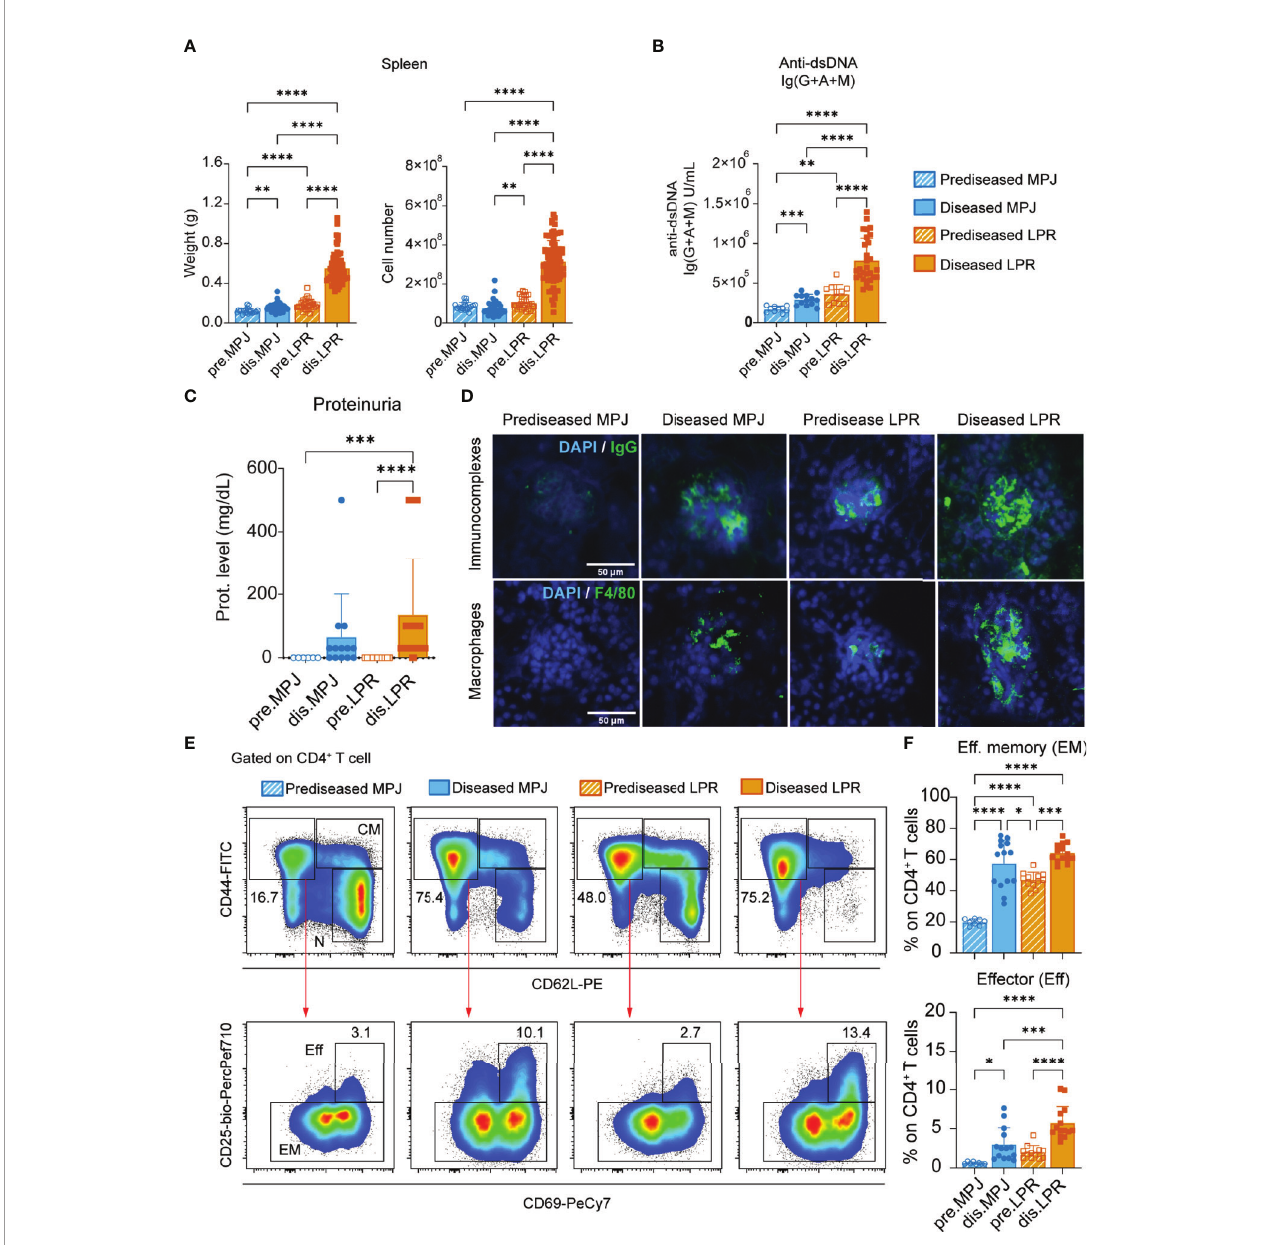
FIGURE 1 | Characterization of MPJ and LPR mice differentiating two lupus disease states. (A) Spleen weight (left) and cell number (right). (B) Levels of Ig(G+A+M) antibodies against double-stranded DNA (dsDNA) determined by ELISA. (C) Protein concentration in urine (0, 30, 100, and 500 mg/dl) determined using urine dipsticks. (D) Representative immuno fl uorescence images from frozen kidney sections (4 – 10 µm) stained with DAPI (4 ′ ,6-diamidino-2-phenylindole) (blue), goat anti- mouse IgG (green) for immunocomplexes (top), and a primary rat anti-mouse F4/80 with secondary goat anti-rat IgG (green) for macrophages (bottom). Scale bar is 50 µm. (E) Representative fl ow cytometry plots gated on splenic CD4 + T cells (CD3 + B220 − CD8 − CD4 + ) showing effector (Eff), effector memory (EM), central memory (CM), and naïve (N) gates. (F) Proportion of effector (Eff: CD44 + CD62L − CD25 + CD69 + ) and effector memory (EM: CD44 + CD62L − CD25 − ) phenotypes among splenic CD4 + T cells. The data represent the mean ± SD: *P < 0.05; **P < 0.01; ***P < 0.001; ****P < 0.0001 by one-way ANOVA with a Tukey multi-comparison post-test. Each point represents a single animal: prediseased MPJ (pre.MPJ), n = 20 (A) 10 (B) 6 (C) and 8 (E, F) diseased MPJ (dis.MPJ), n = 40 (A) 13 (B) 13 (C) and 14 (E, F) ; prediseased LPR (pre.LPR), n = 31 (A) 11 (B) 12 (C) and 12 (E , F) diseased LPR (dis.LPR), n = 74 (A) 29 (B) 38 (C) and 14 (E, F)